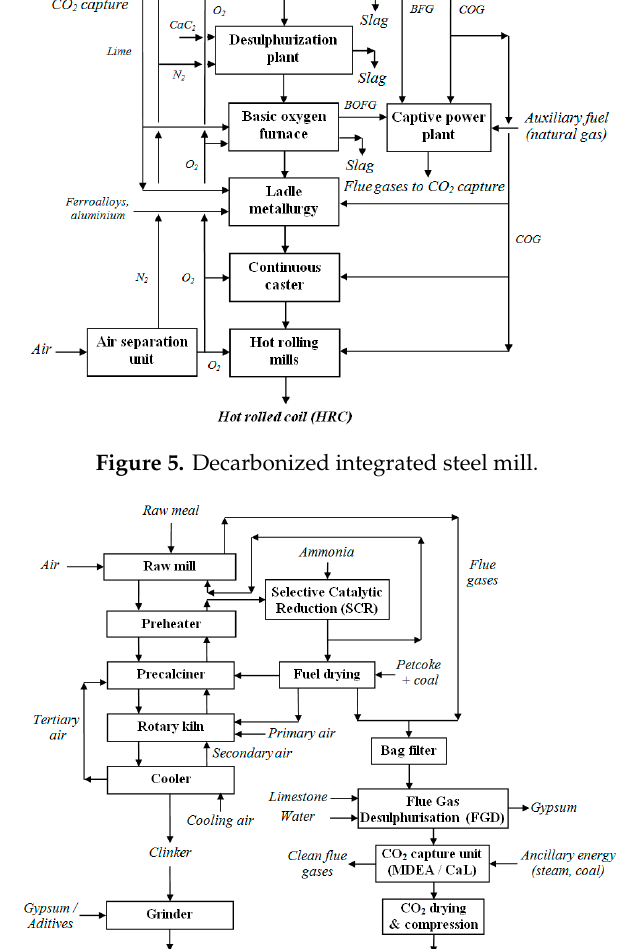
Figure 5. Decarbonized integrated steel mill.